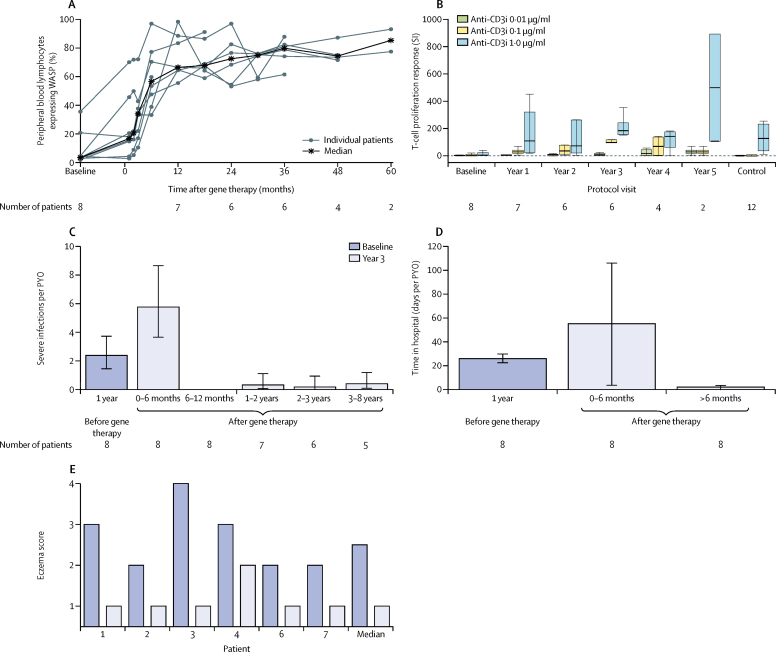
Immune reconstitution and clinical benefitGene therapy was administered on day 1 (month 0). (A) Percentage of peripheral blood lymphocytes expressing WASP, as measured by flow cytometry. (B) T-cell proliferation response (expressed as SI) after incubation with increasing concentrations of anti-CD3i antigen, by observation period. Boxes represent upper and lower quartiles (outliers excluded). Horizontal line within the box is the median. Whiskers represent most extreme points ≤1·5 × IQR. Control data are from 12 healthy children. (C) Rate of severe infections (events per PYO) for each observation period. Error bars represent the 95% CI. (D) Number of days in hospital (days per PYO) for each observation period. Error bars represent the 95% CI. (E) Eczema scores are 1 (absent), 2 (mild), 3 (moderate), and 4 (severe). Six patients were followed up for at least 3 years after gene therapy. WASP=Wiskott-Aldrich syndrome protein. SI=stimulation index. Anti-CD3i=anti-immobilised CD3. PYO=patient-year of observation.